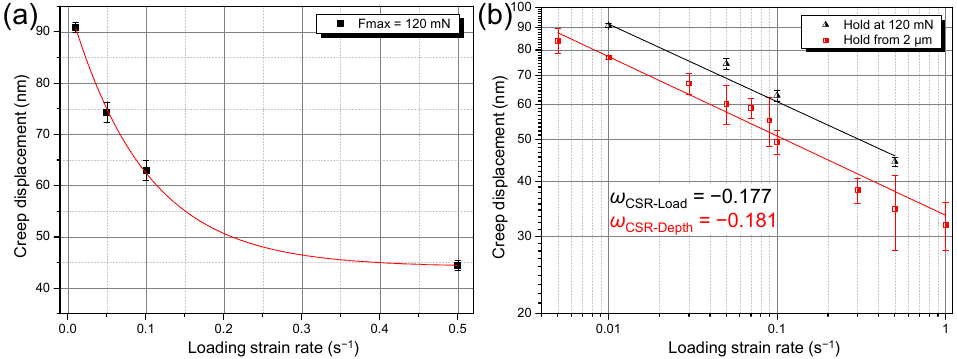
Figure 9. Strain rate dependence of room temperature indentation creep displacements of the RS NC Mg–Gd–Y–Zr alloys at fixed F max in ( a ) linear and ( b ) double logarithmic coordinate system.